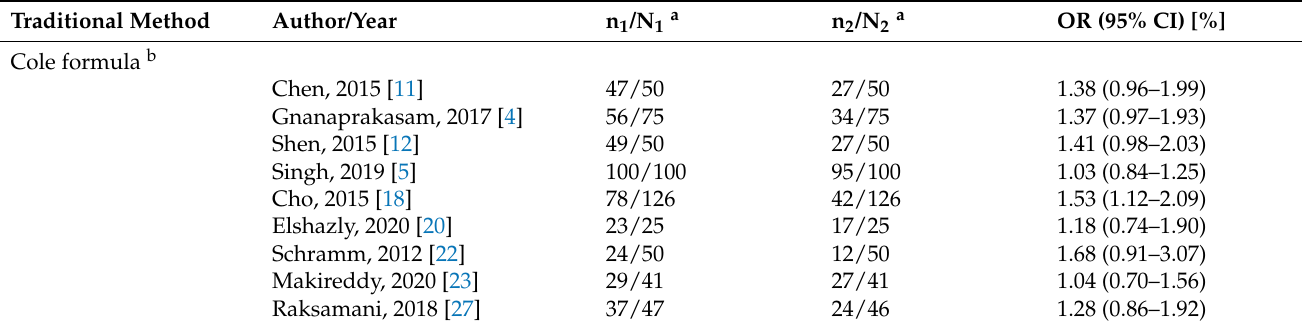
Table 1. Diagnostic accuracies of airway ultrasound and traditional methods are shown as odds ratio (OR) and 95%